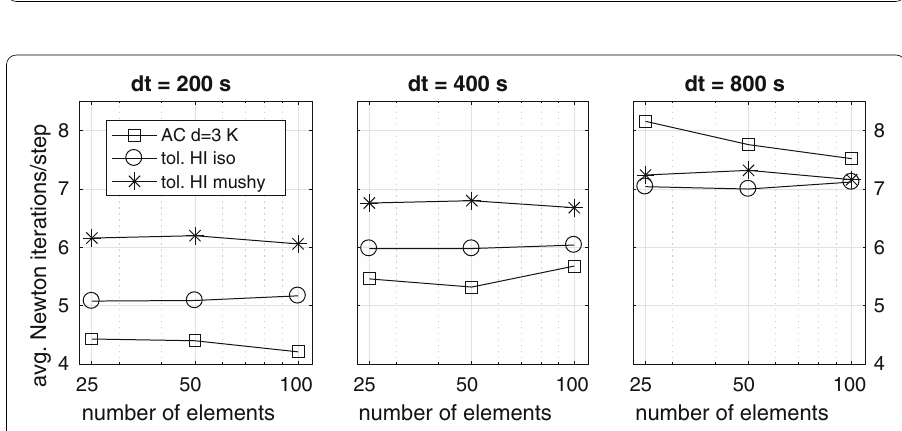
Fig. 13 Melting volume example: average number of iterations of best performing methods for latent heat depending on spatial and temporal discretization